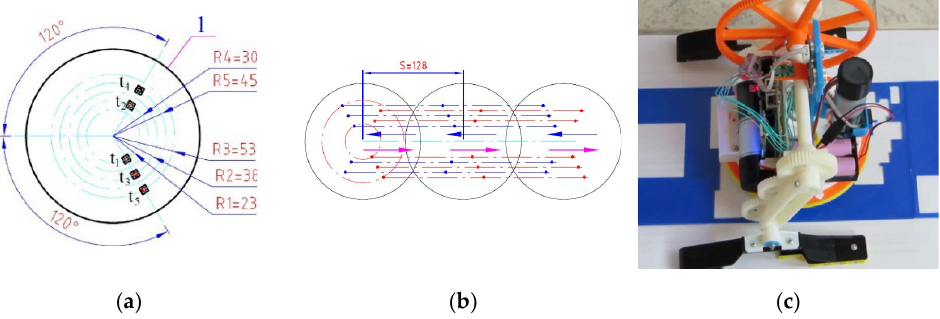
Figure 2. Location of the tactile sensors ( t i ; i = 1 − 5) on the base of the robot “Big Foot” ( a ); exemplary trajectory for scanning of bumps ( b ); experiment using the robot for scanning light unevenness on the surface ( c